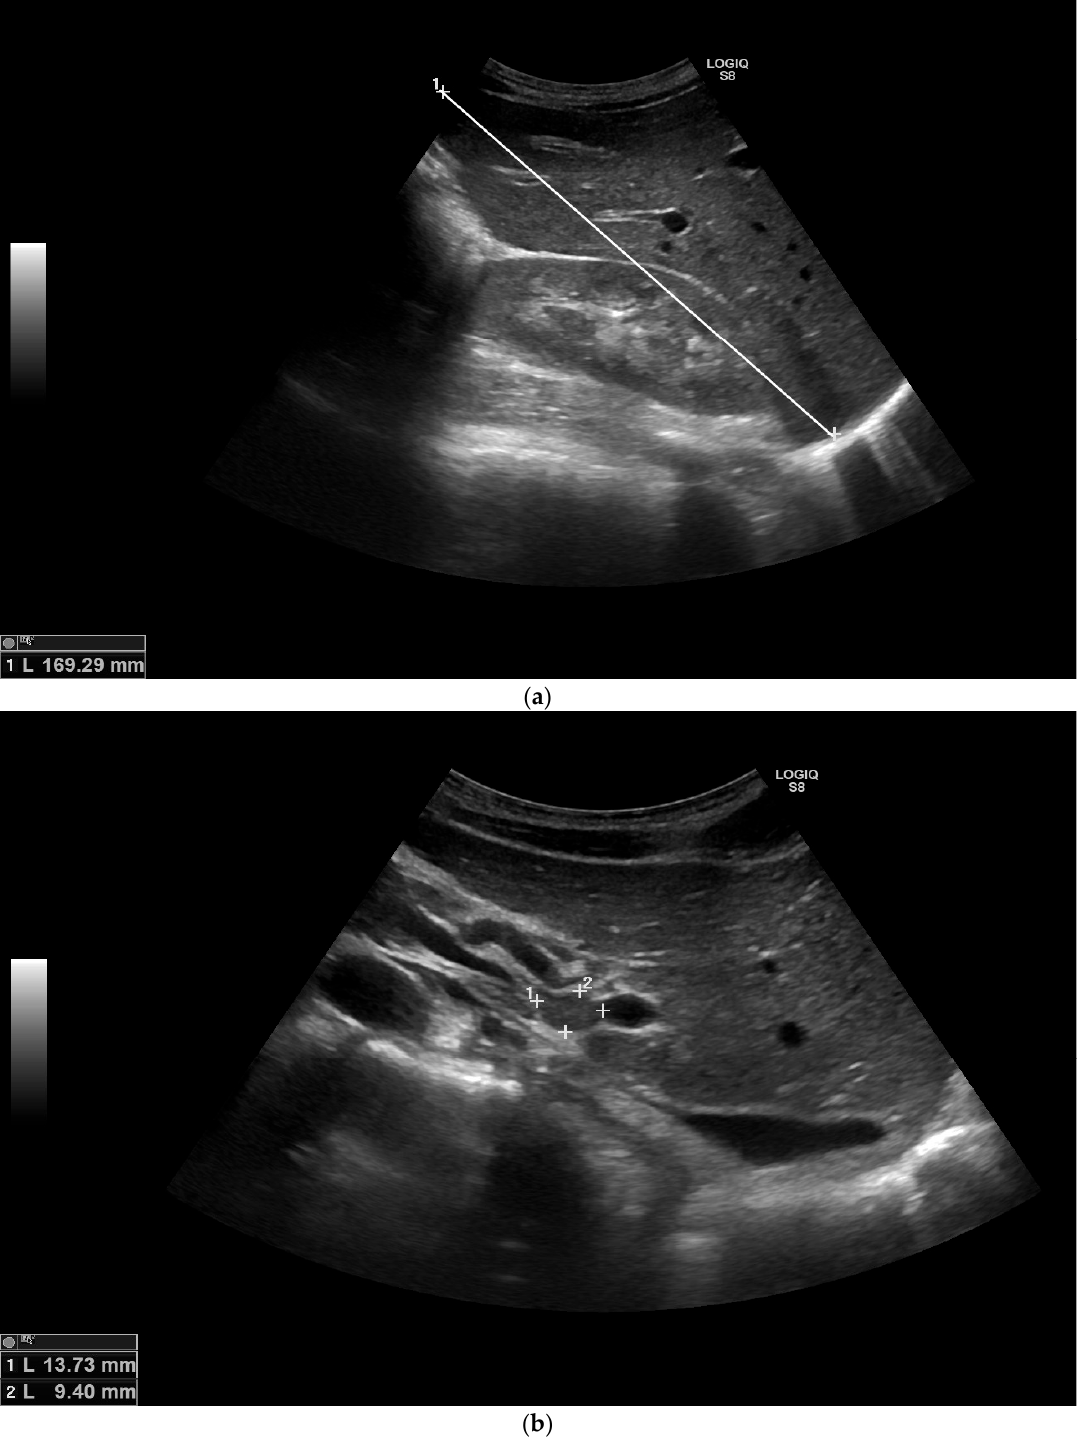
Figure 1. ( a ) Ultrasound of the abdomen showing hepatomegaly: liver diameter is 169.29 mm in the midclavicular line (normal range < 150.00 mm). ( b ) Ultrasound of the abdomen showing portal hepatic lymphadenopathy: lymph node dimensions 13.73 × 9.40 mm.